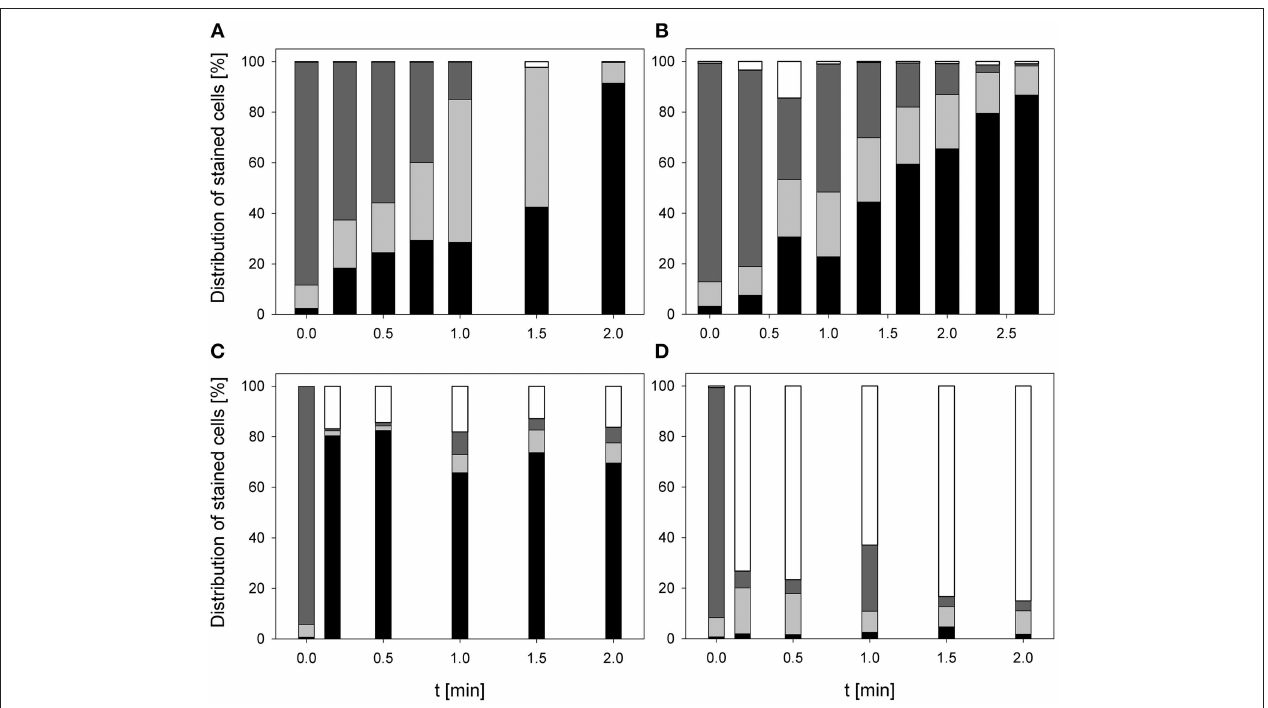
FIGURE 4 | Membrane integrity of P. carotovorum after PAA treatment [(A) 10 ◦ C, 0.25% PAA], CAPP treatment [(B) 20 W], and treatment with ozonated water [(C) 2.8mg l − 1 O 3 (–); (D) 3.8mg l − 1 O 3 ( + )]. Black bars representing permeabilized cells; gray bars representing slightly permeabilized cells, light gray bar representing intact cells, and white bars representing cells without fluorescence/cell